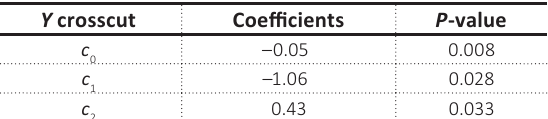
Table 3. Debt/FDI regression indicators